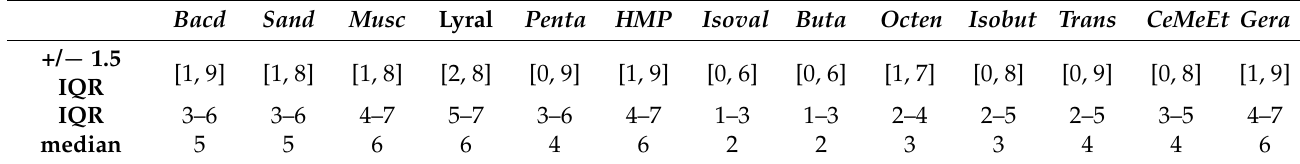
Table 4. Interquartile Ranges for Pleasantness Ratings.